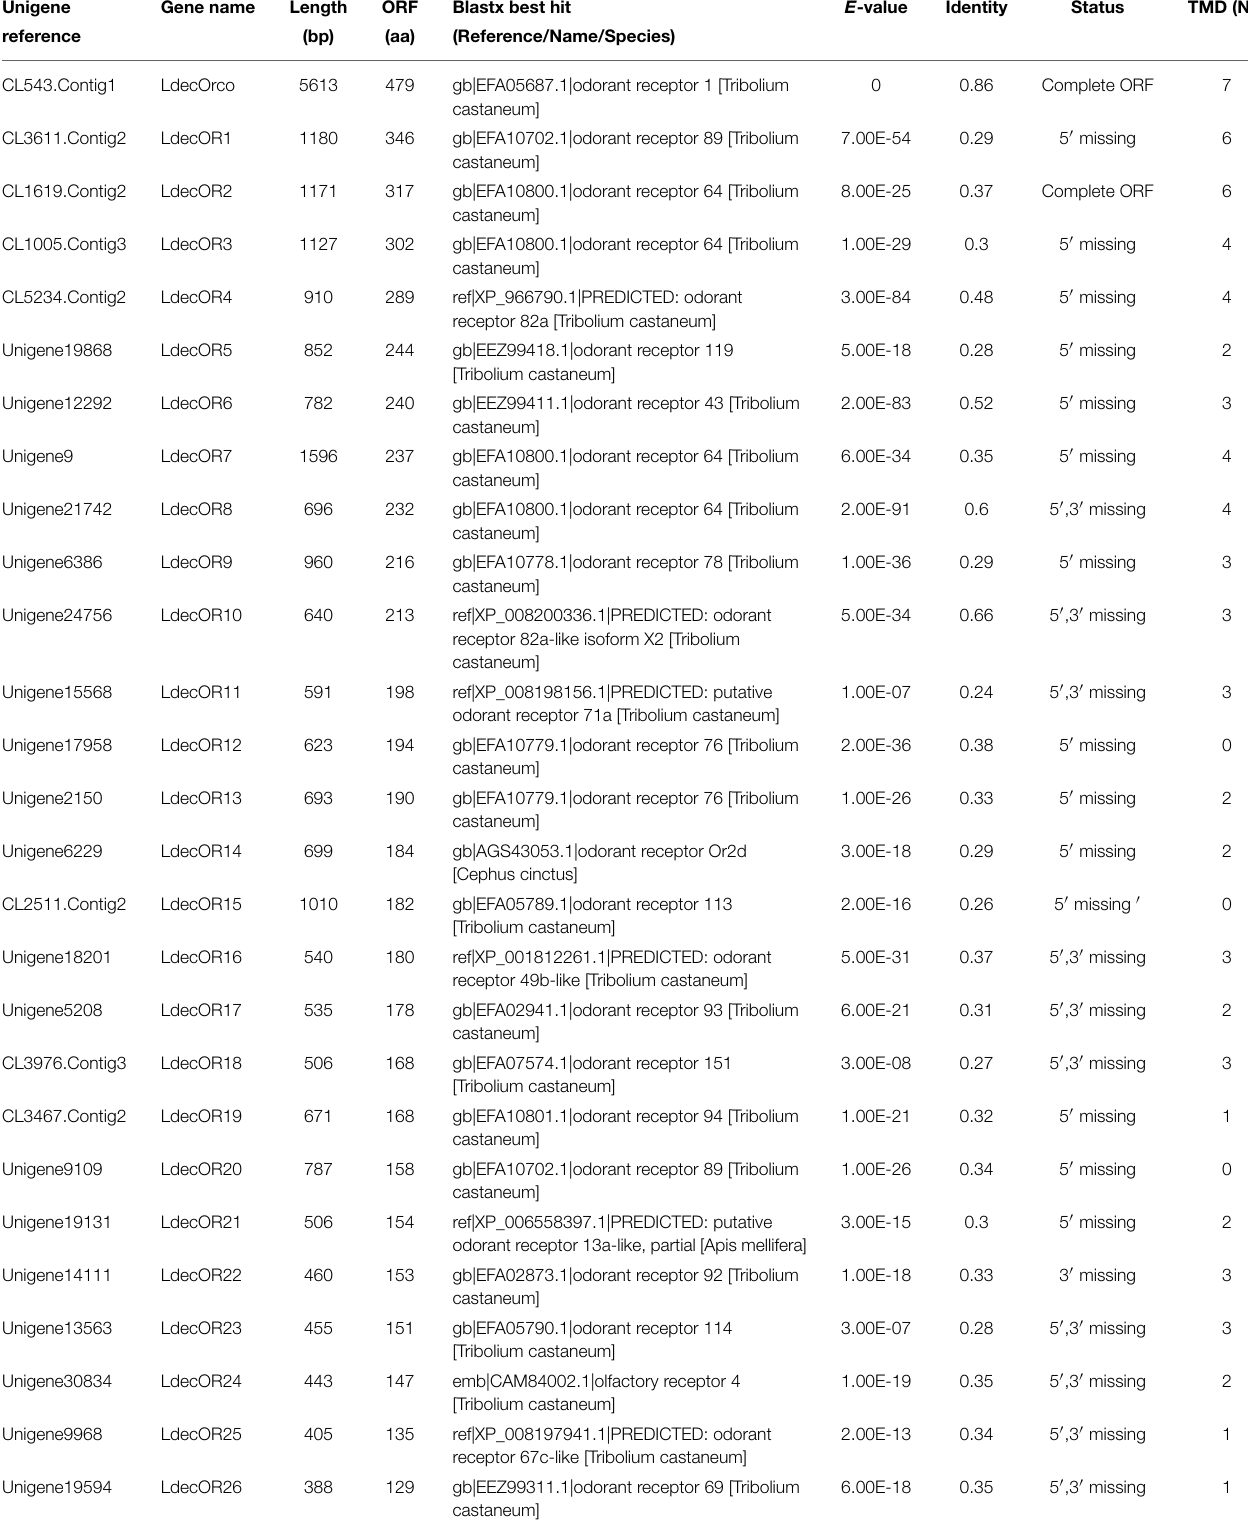
TABLE 5 | Unigenes of candidate odorant